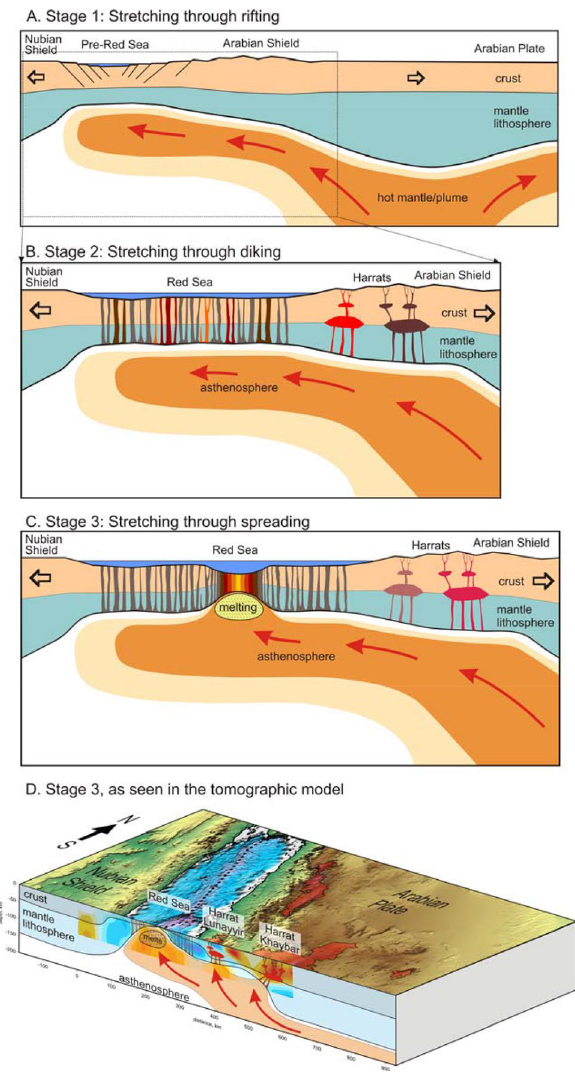
Figure 3. Schematic representation of three stages of extension of the transition from continental rifting to oceanic spreading (panels A – C ). The interpretation in panel ( D ) is based on the results of seismic tomography obtained in this study. See details in the text. The images have been created in Corel Draw